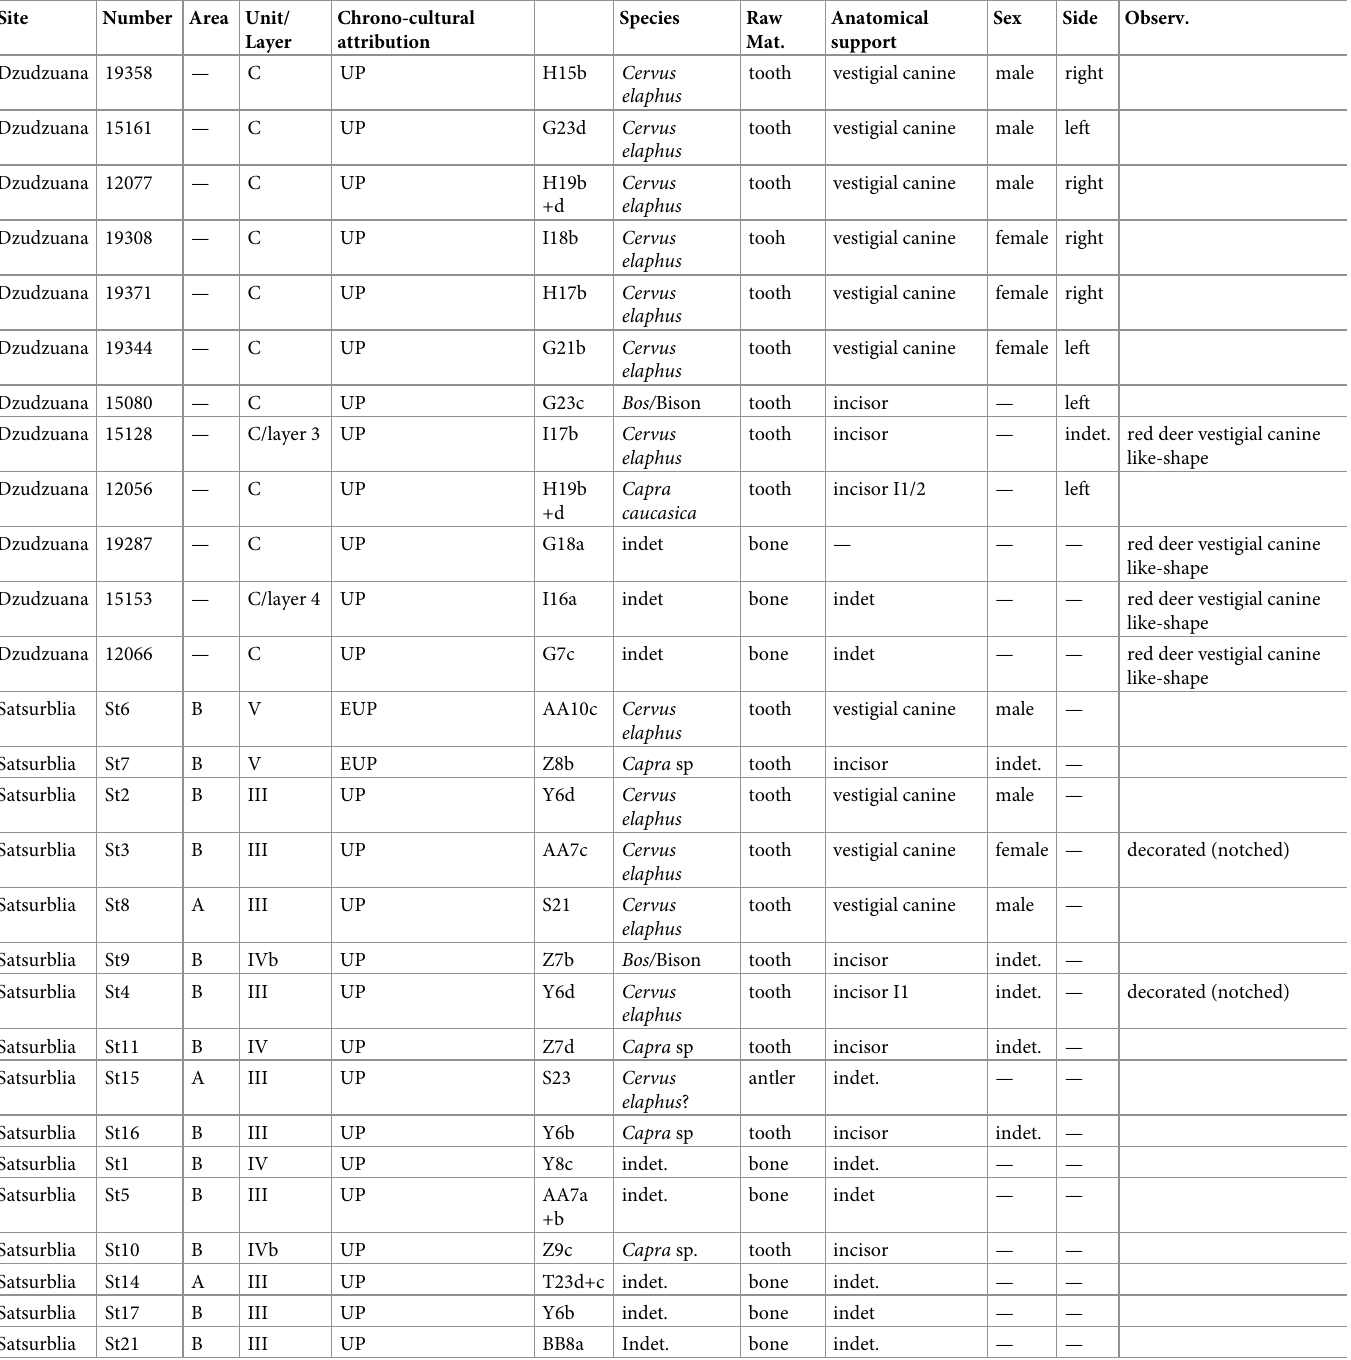
Table 1. Pendants from Dzudzuana and Satsurblia caves. Site Number Area Unit/